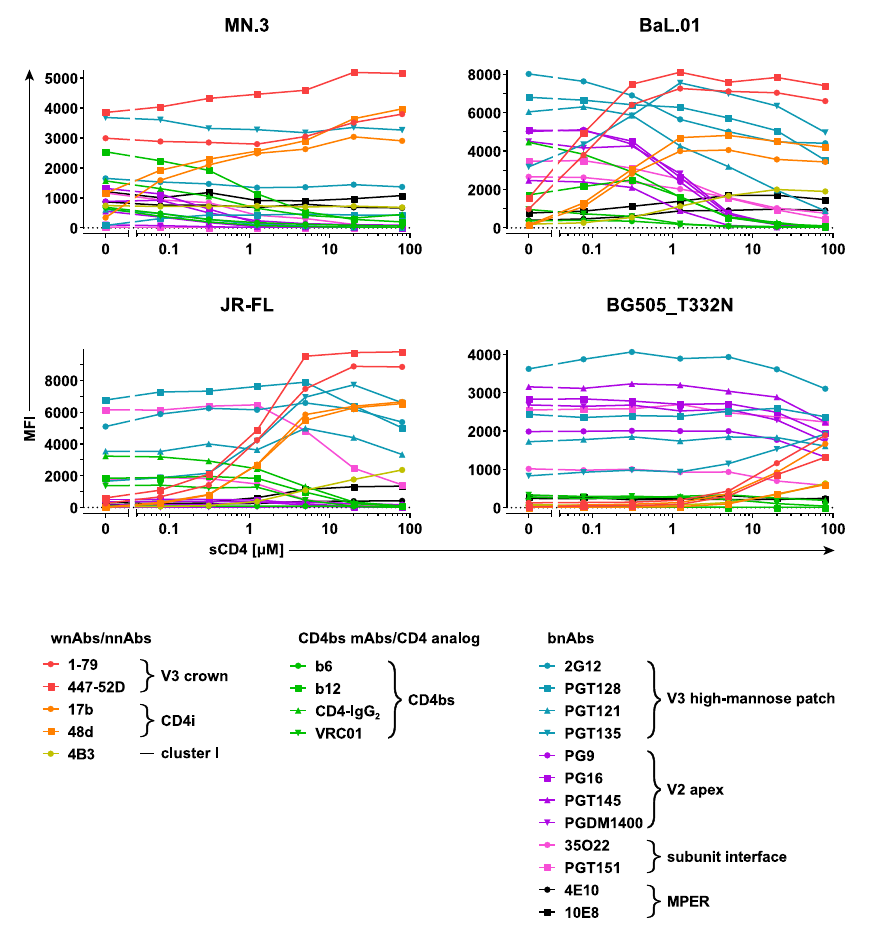
Fig 4. Comparison of the antigenic profiles and CD4-unbound state stability of divergent Envs. On-cell sCD4 triggering of MN.3, BaL.01, JR-FL, and BG505_T332N Envs and assessment of antibody/inhibitor binding at 10 μ g/ml with a 20-minute triggering step. MFI staining curves were derived as described in Fig 1. Respective relative MFI staining curves are depicted in S7 Fig and histogram plots of the event distributions in S8 Fig. Data represent a single experiment. BG505_T332N, BG505.W6M.ENV.C2_T332N; CD4bs, CD4 binding site; CD4i, CD4-induced site; Env, envelope glycoprotein; mAb, monoclonal antibody; MFI, mean of fluorescence intensity; MPER, membrane-proximal external region; nnAb, nonneutralizing antibody; sCD4, soluble CD4; V2, second hypervariable; V3, third hypervariable; wnAb, weakly neutralizing antibody.